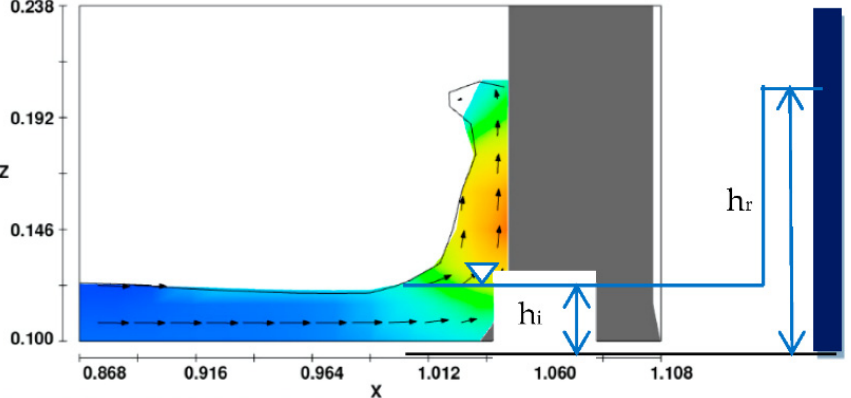
Figure 7. Formation of incident and reflected waves. On the other hand, Armanini [20] suggested the following equation to estimate the impact force acting on a vertical wall based on the hypothesis of hydrostatic pressure dis- tribution: